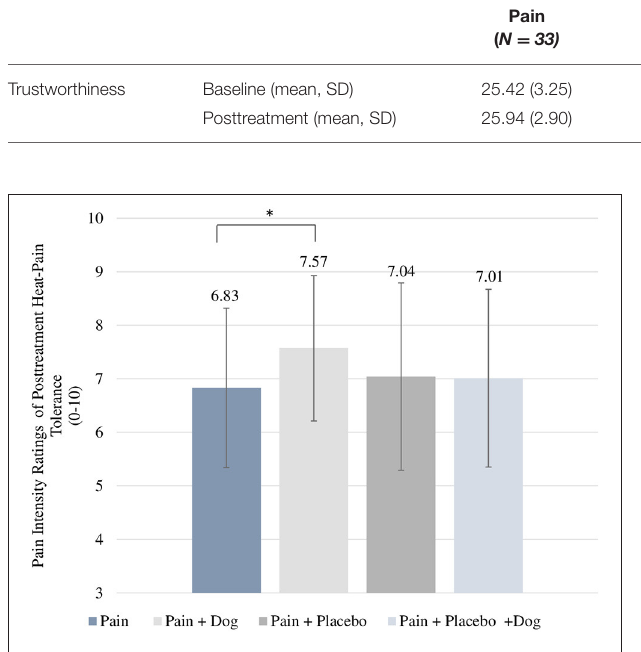
FIGURE 3 | Posttreatment scores of subjective intensity ratings for heat-pain tolerance. For each condition, the respective mean and standard deviation are displayed. * p -value <